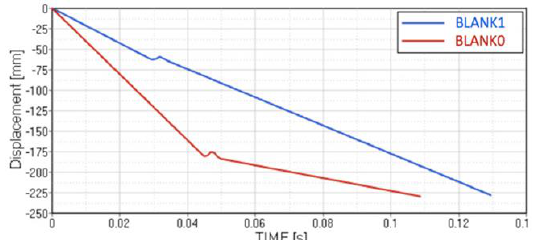
Figure 28. Displacement vs time comparison for the optimal combination (according to the regression model) for blank0 and blank1 plan.